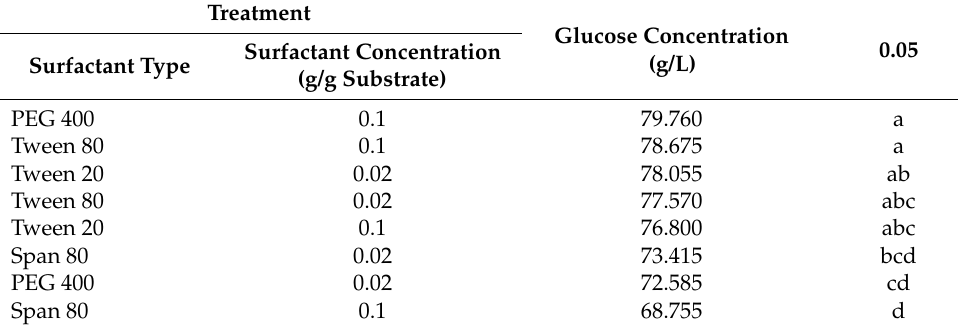
Table 4. Tukey multiple comparison test for surfactant